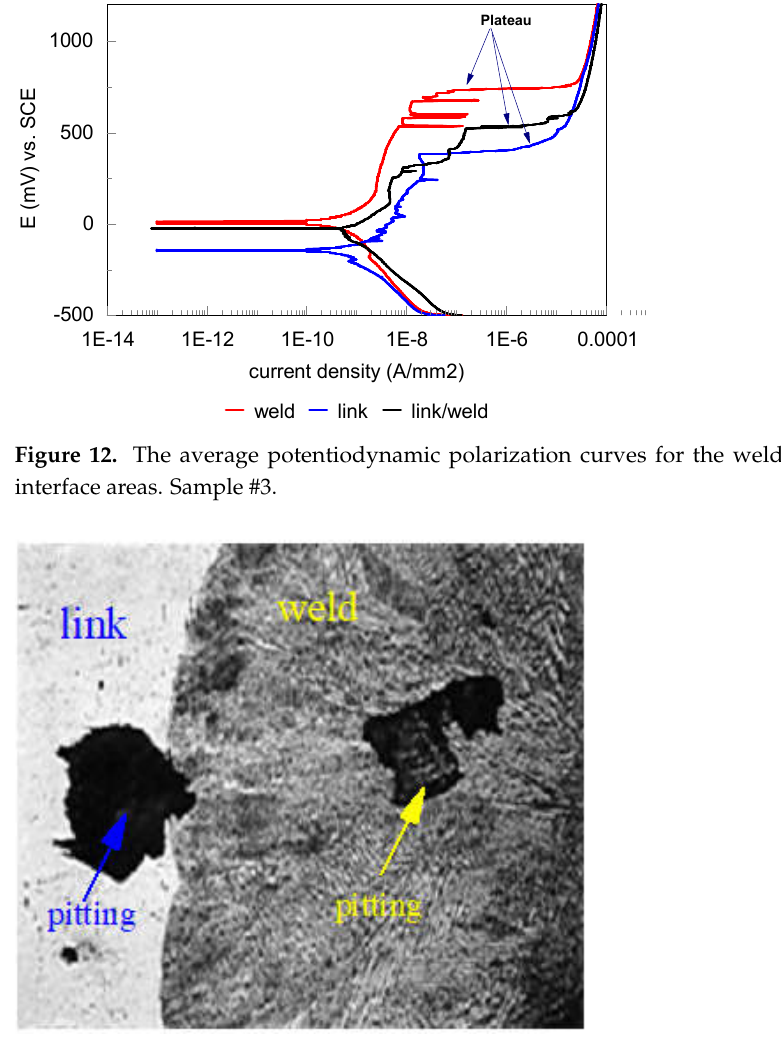
Figure 13. Pitting corrosion of the link/weld interface of the transversal surface in Test 1. Optical examination, magnification 40 × , Sample #3.